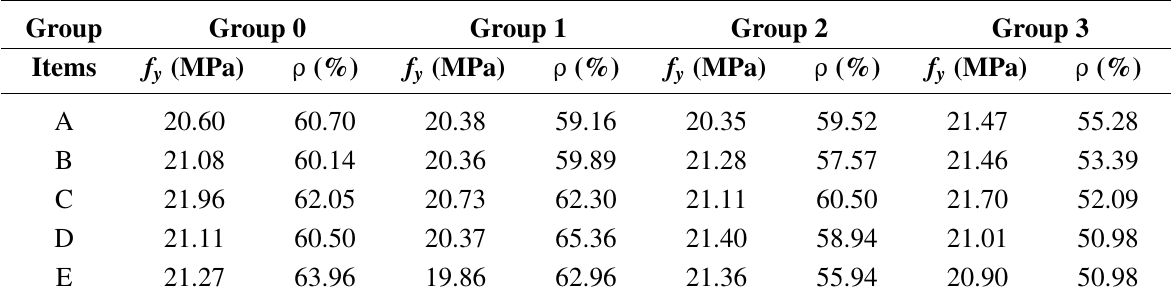
Table 3. HDPE tensile performance after aging and fatigue tests.